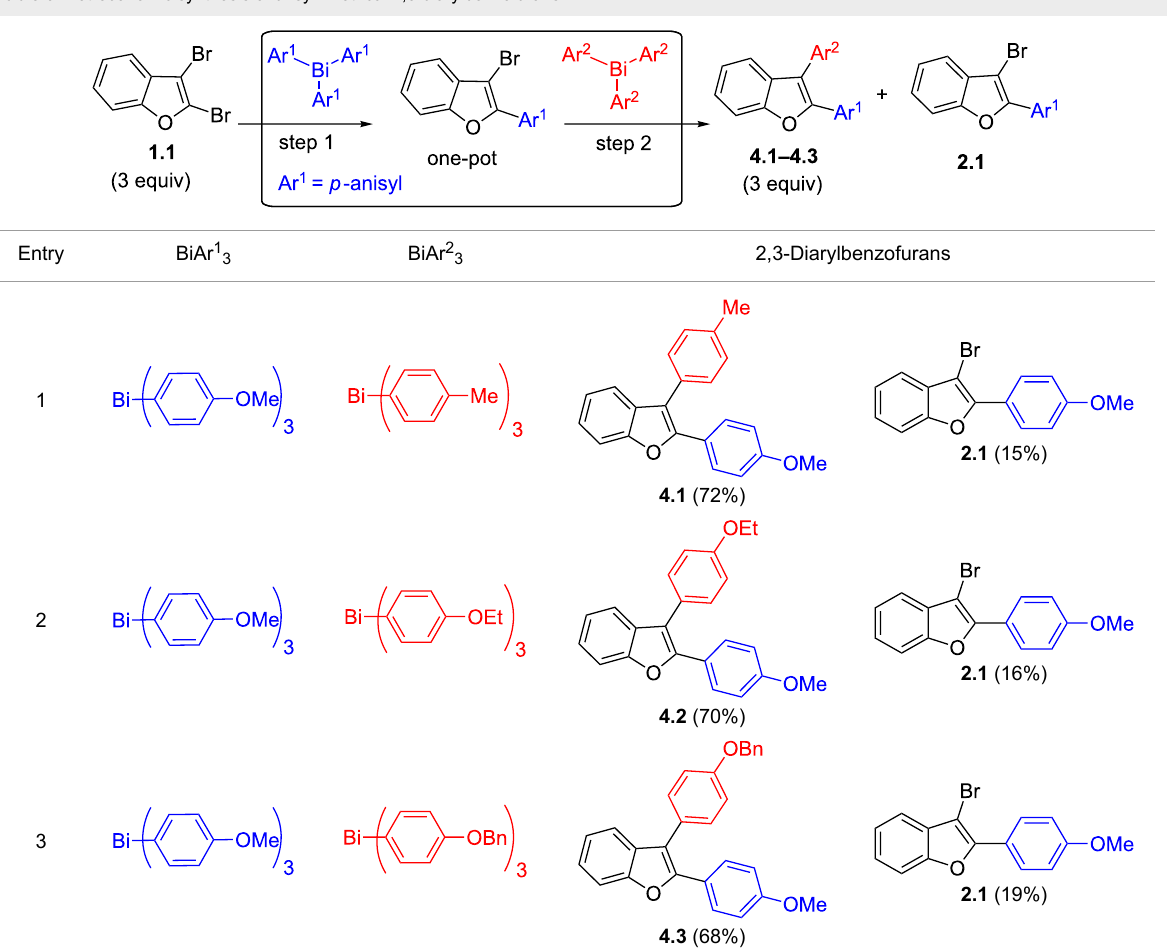
Table 6: Pot-economic synthesis of unsymmetrical 2,3-diarylbenzofurans. a